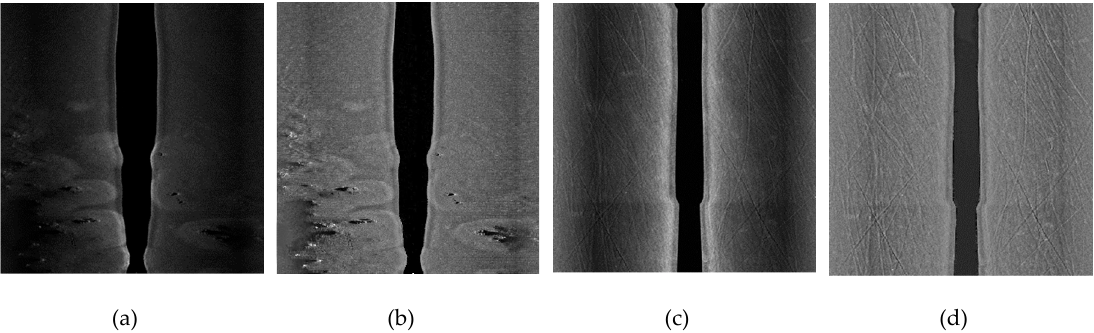
Figure B2. Side-scan sonar image enhancement from previous studies [7,8]: (a) original and (b) Figure A2. Side-scan sonar image enhancement from previous studies [7,8]: ( a ) original and ( b ) enhanced image from Capus, C et al. [7]; (c) original image and (d) enhanced image from Capus, C et enhanced image from Capus, C et al. [7]; ( c ) original image and ( d ) enhanced image from Capus, al. [8] (bilateral filtering, A = 140, a = 15). C et al. [8] (bilateral filtering, A = 140, a =